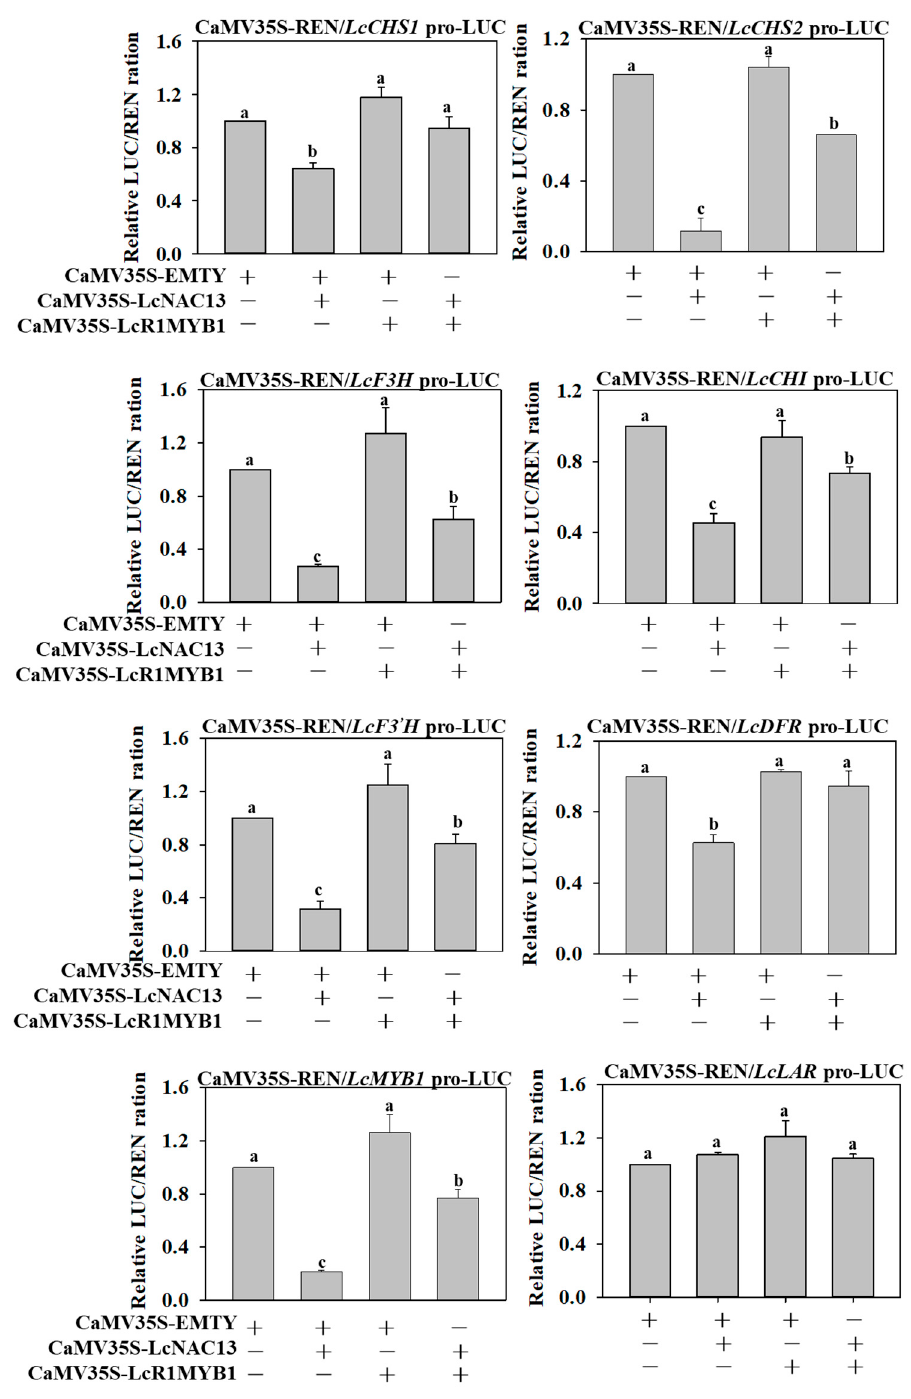
Figure 6. Transient expression assays demonstrate the function of LcNAC13 and LcR1MYB1 in transcriptional regulation of anthocyanin biosynthesis-related genes in vivo. Repression or activation of LcNAC13 or LcR1MYB1 to the promoters of anthocyanin biosynthesis-related genes were shown by the ratio of LUC to REN. The ratio of LUC to REN of the empty vector plus promoter vector was used as a calibrator (set as 1). Different letters above the bars represent a difference ( p < 0.05). Each value represents the mean + standard error of six biological replicates.